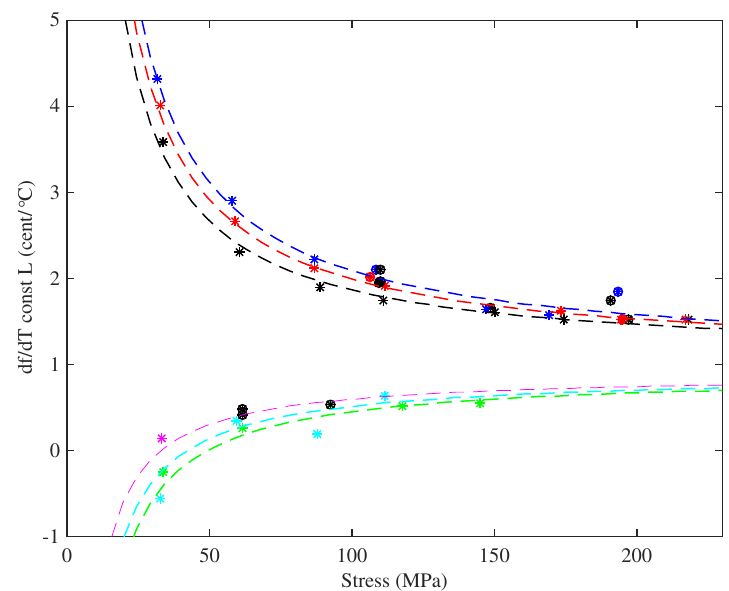
Figure 13. The thermal tuning sensitivity, plotted against the applied stress, for the strings held at constant length with no tuning adjustments. The y -axis shows the rate of change of fundamental frequency f 1 with temperature T . Colours identify the di ff erent tested strings (Table 1): black (8:A6), red (14:A5), blue (5:A4), green (23a:A3), cyan (29:E3), magenta (10b:A2). Black circles show the results at the expected operating points for the Bowbrand strings tested at the usual humidity levels (around 55–65% RH at 20 ◦ C); blue circles show Pirastro strings; red circles show tests at low humidity (around 20–26% RH at 20 ◦ C). The dashed lines show estimated responses obtained using Equation